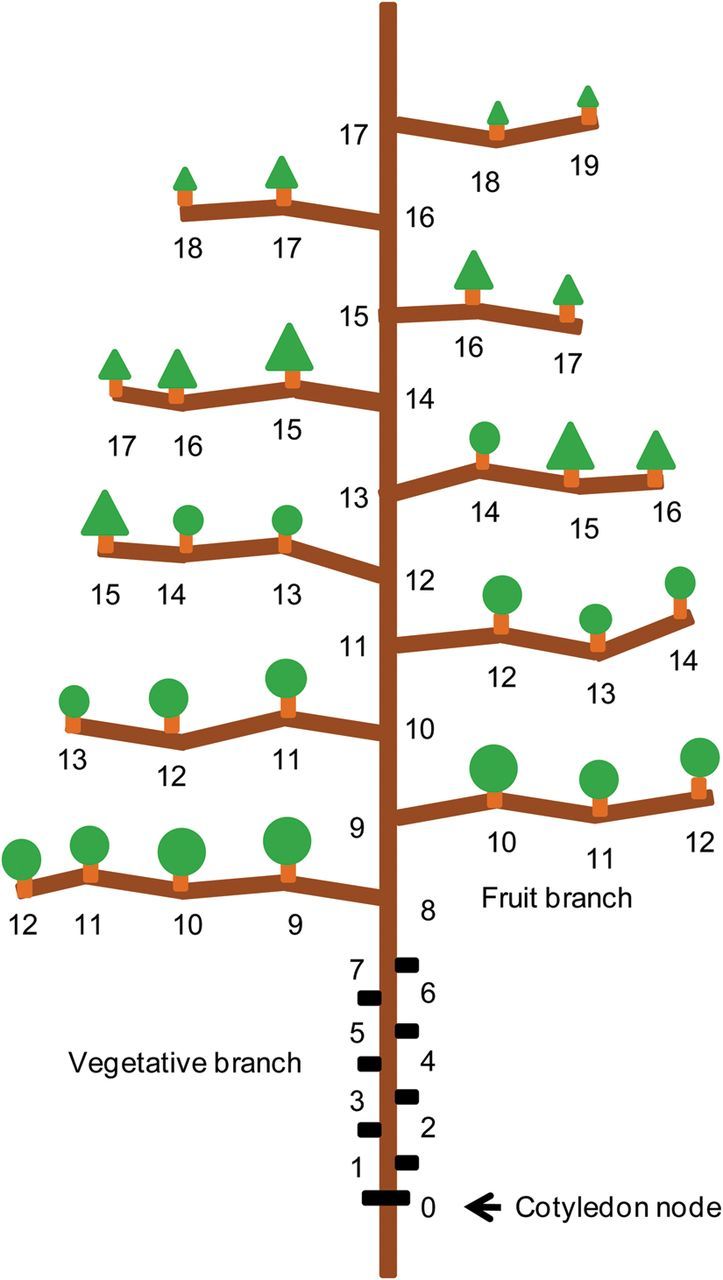
Cumulative phytomer number of fruits in cotton plants, counted from the cotyledon node.